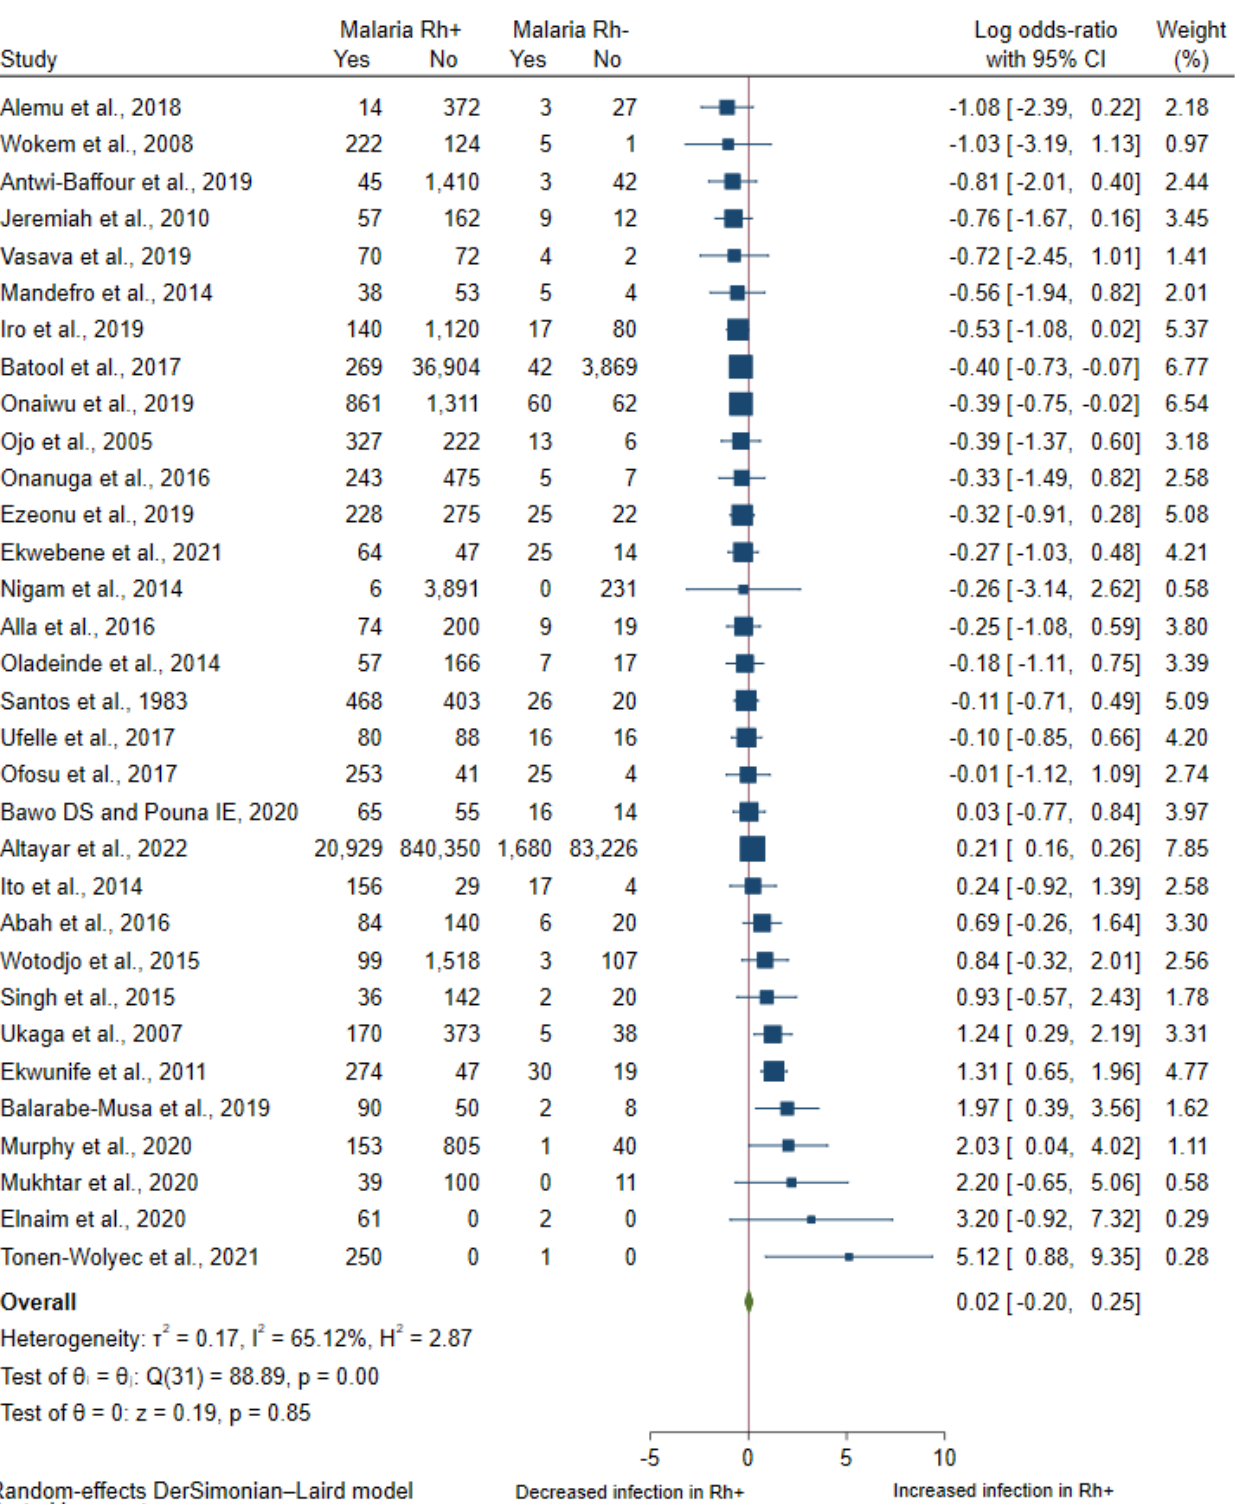
Figure 2. Forest plot demonstrating the odds of malaria among individuals with Rh+ and Rh − when a random effects model has been used. Abbreviations: OR, odds ratio; CI, confidence interval. [21,23–27,29–34,37–56]